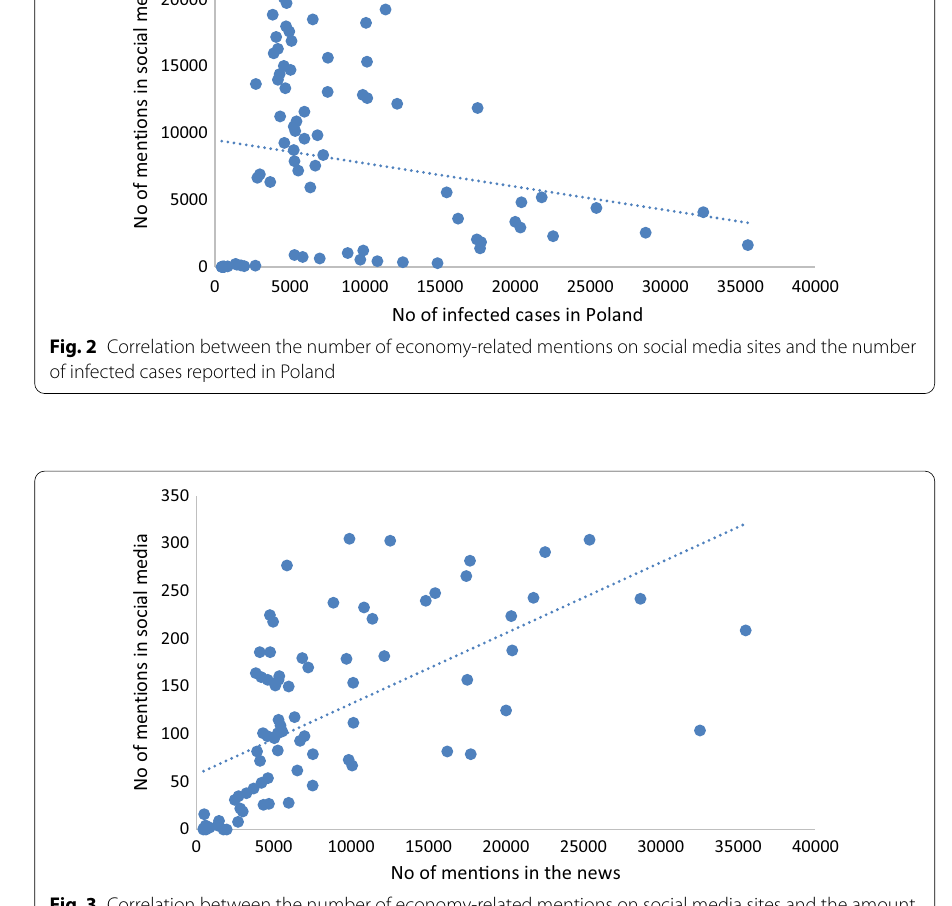
Fig. 3 Correlation between the number of economy-related mentions on social media sites and the amount of economy-related online